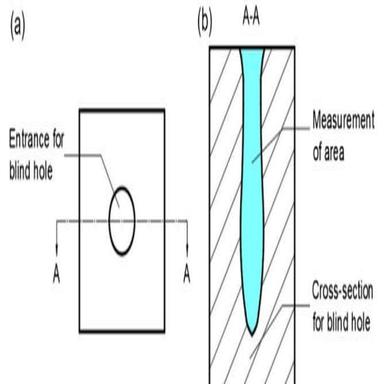
Illustration of (a) entrance and (b) diametric section area measurement